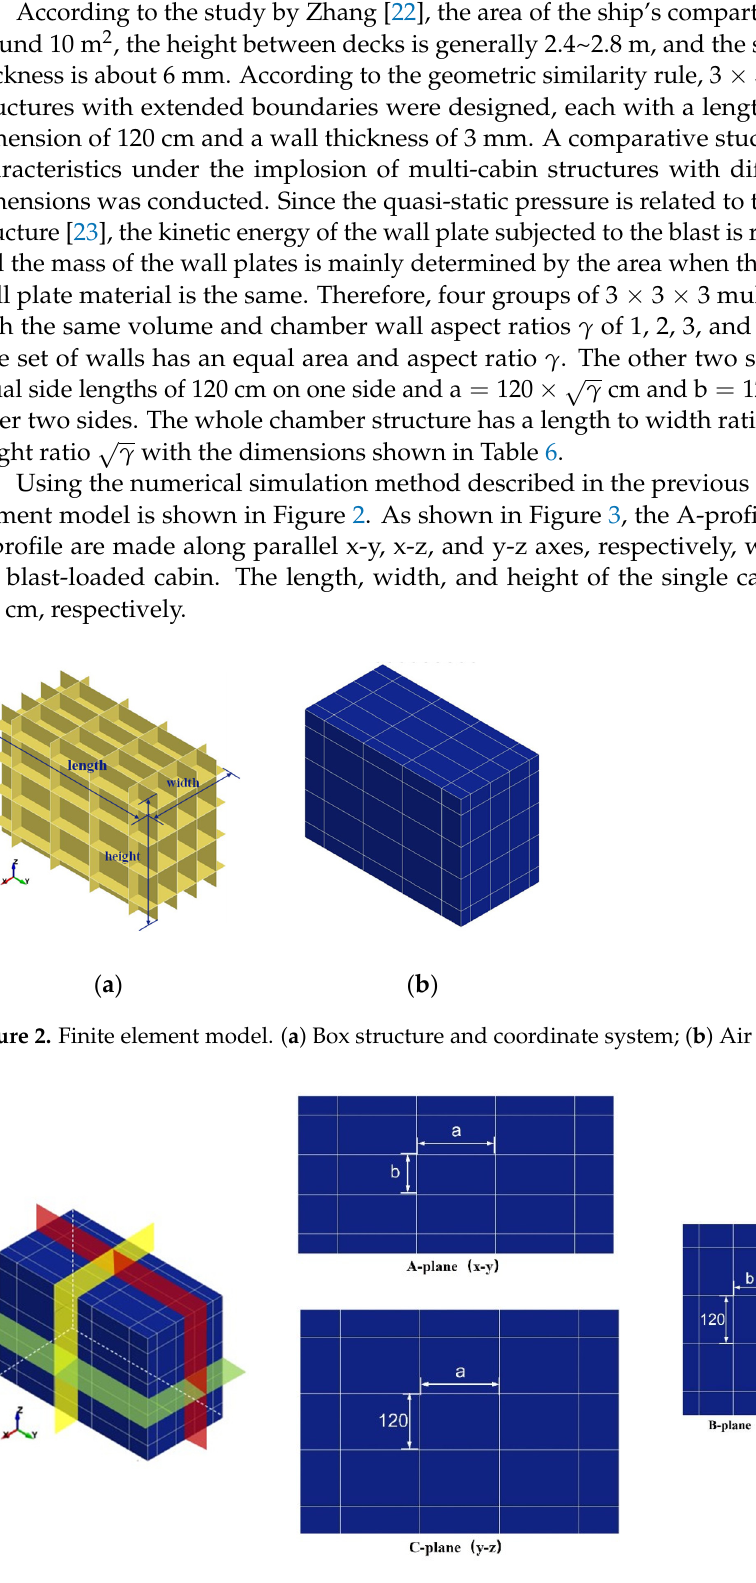
Figure 3. Multi-box structural section and structural dimensions (Unit: cm).